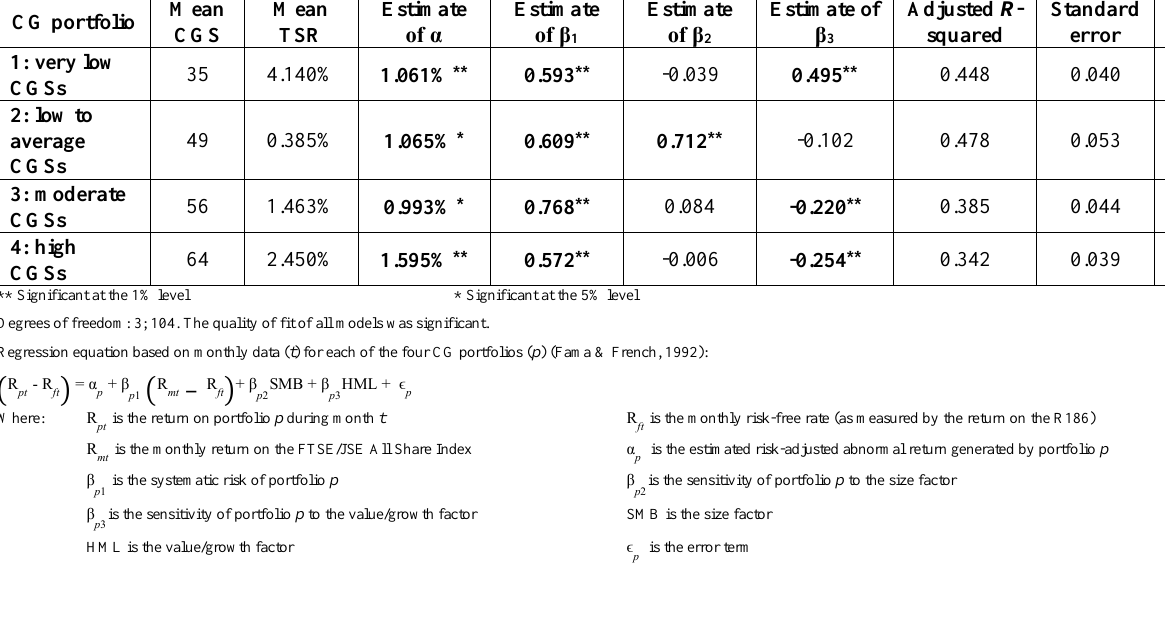
Table 7: Fama-French three-factor model estimation results CG